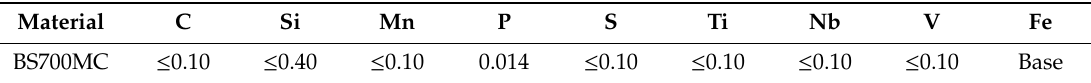
Table 1. Chemical composition of experimental BS700 hot-rolled plates.